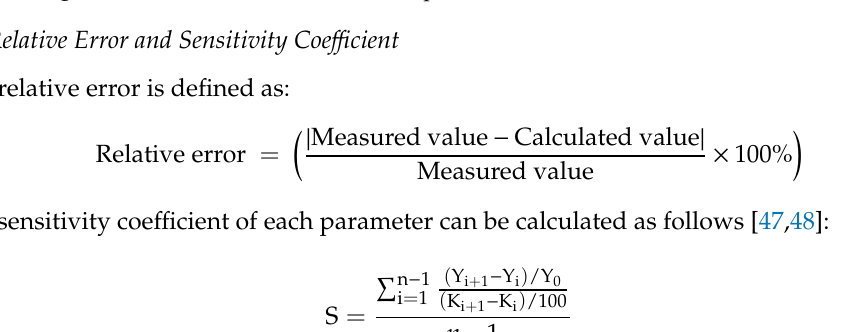
Figure 6. Distribution of standardized predicted values and standardized residual.